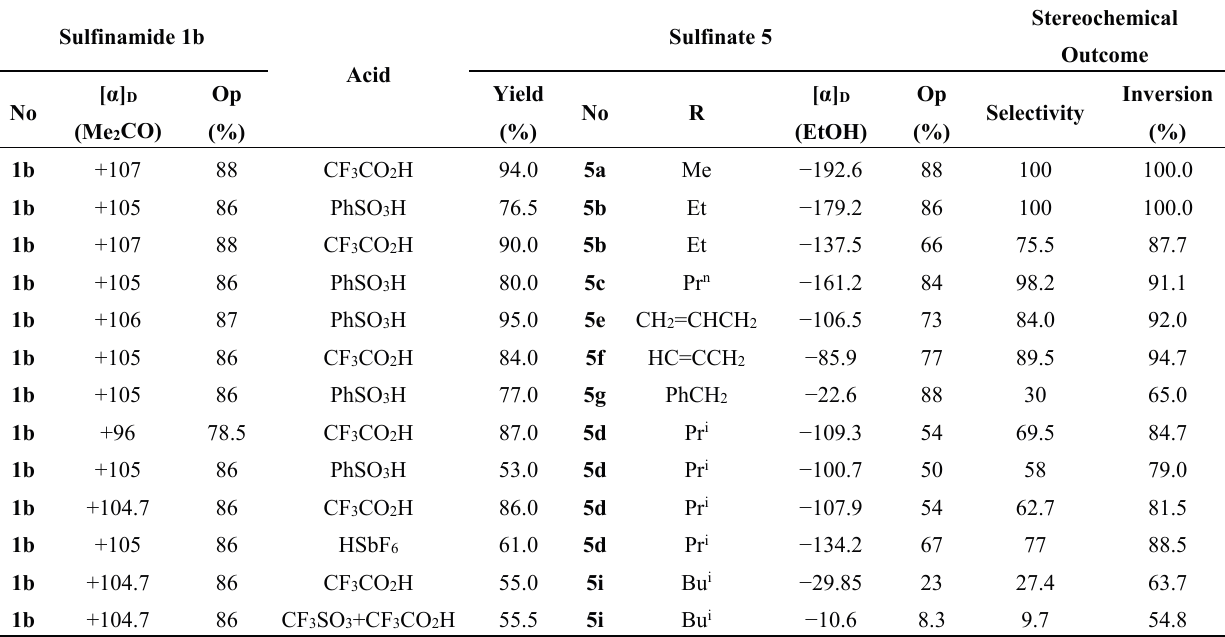
Table 2. Stereoselective synthesis of optically active (+)-( S ) O -alkyl p -toluenesulfinates ( 5 ) from sulfinamide (+)-( S )- 1b